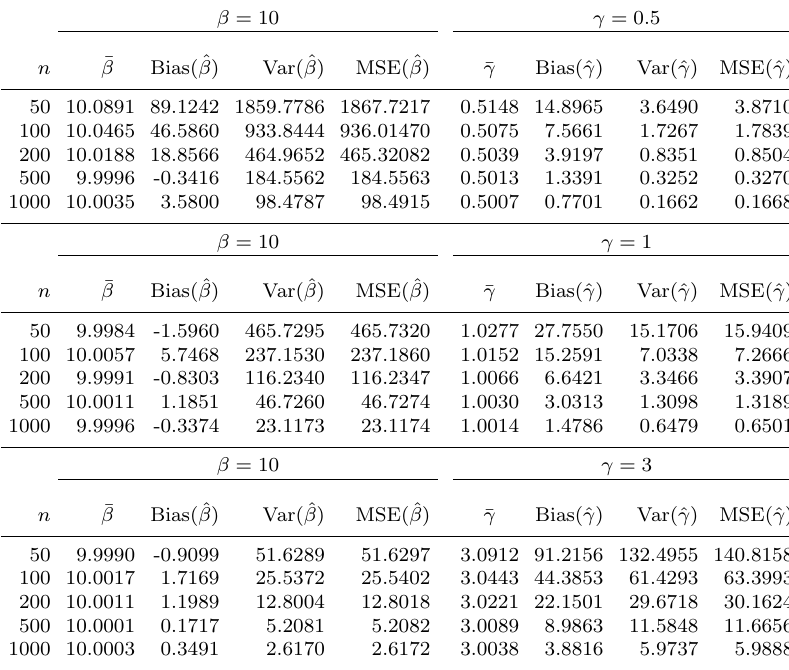
Table 1. ML parameter